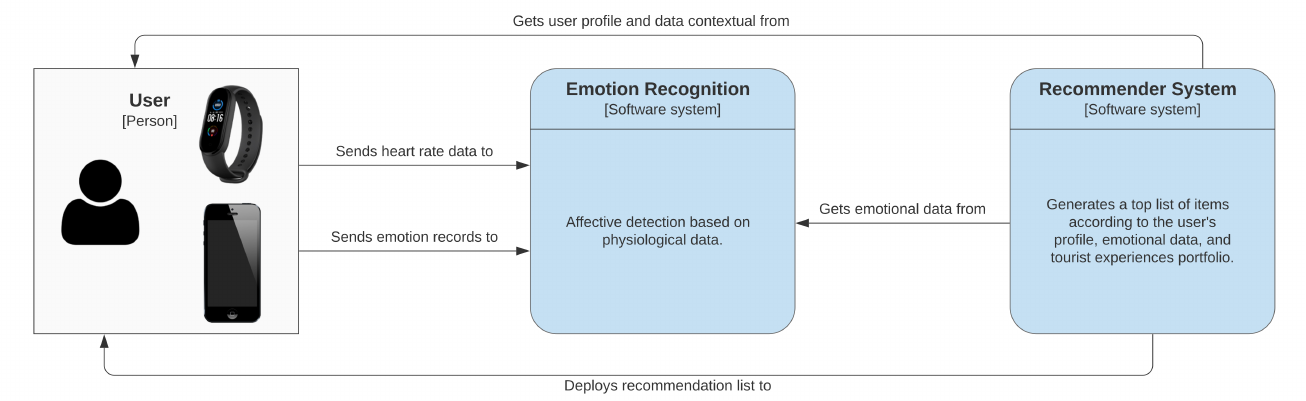
Figure 3. Scenario and